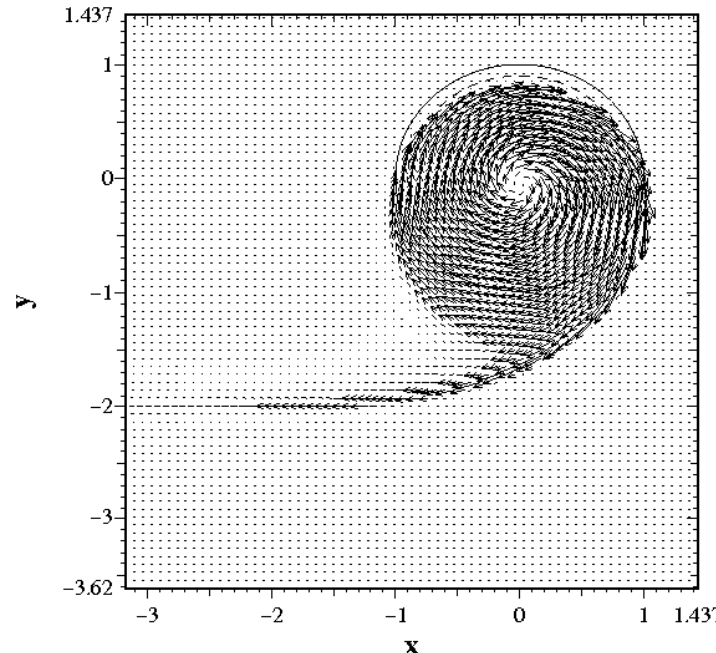
Figure 1. An example of a rather unexpected magnetic configuration produced by dynamo action (axisymmetric within the circle x 2 + y 2 < 1, which is shown) and a streaming velocity in the negative x -direction. This figure appeared in [44] where more examples can be found. The figure is reproduced by permission of